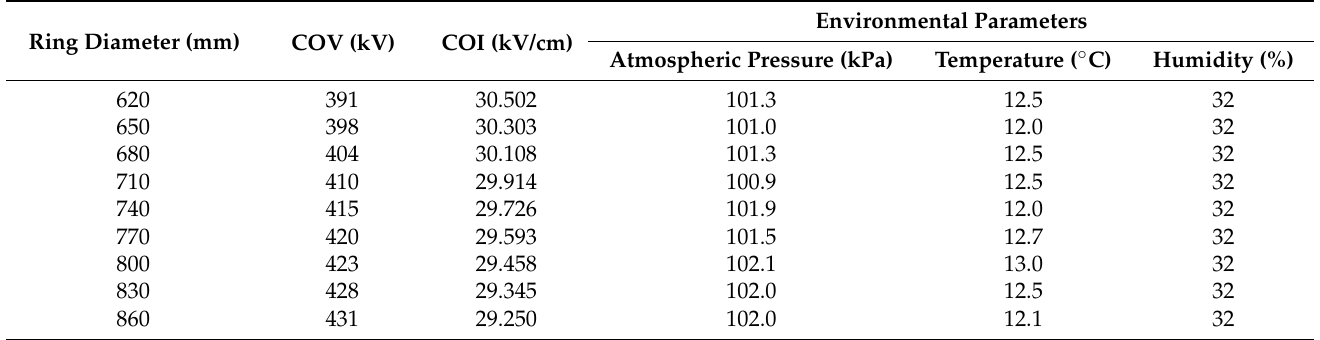
Table 2. COI test results of circular grading rings with pipe diameter of 60 mm and different ring diameters.